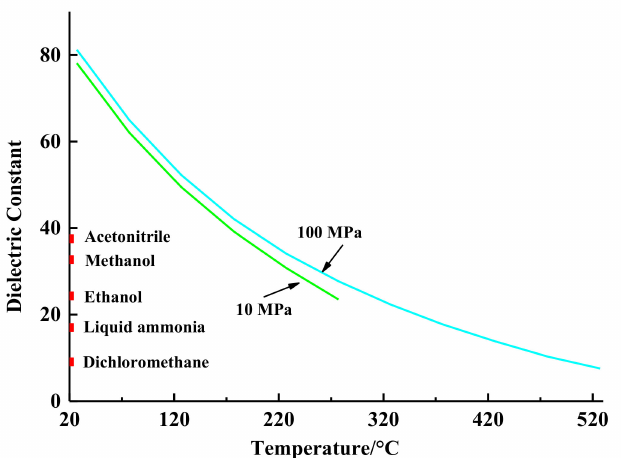
Figure 1. Dielectric constant of water at 27 to 527 ◦ C and 10 to 100 Mpa, acetonitrile, methanol, ethanol, liquid ammonia, and dichloromethane at 20 ◦ C and 0.1